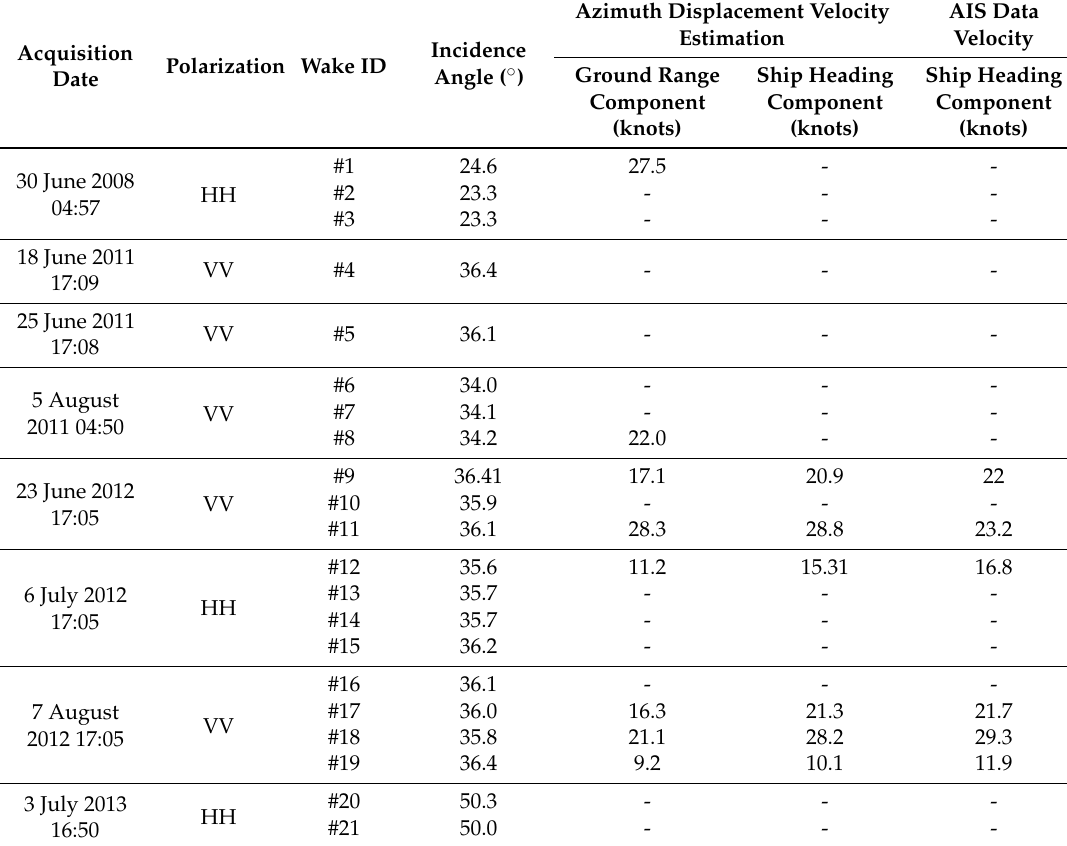
Table 3. COSMO/SkyMed dataset, imaged wakes and velocity estimation results. AIS, Automated Identification System.